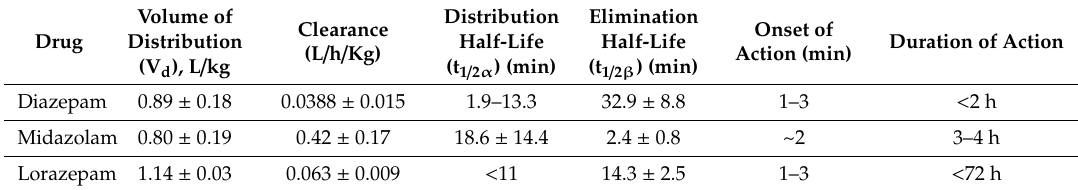
Figure 1. Structure of diazepam ( A ), lorazepam ( B ), midazolam ( C ). Table 1. Pharmacokinetic parameters of diazepam, midazolam and lorazepam following intravenous administration [22,23].